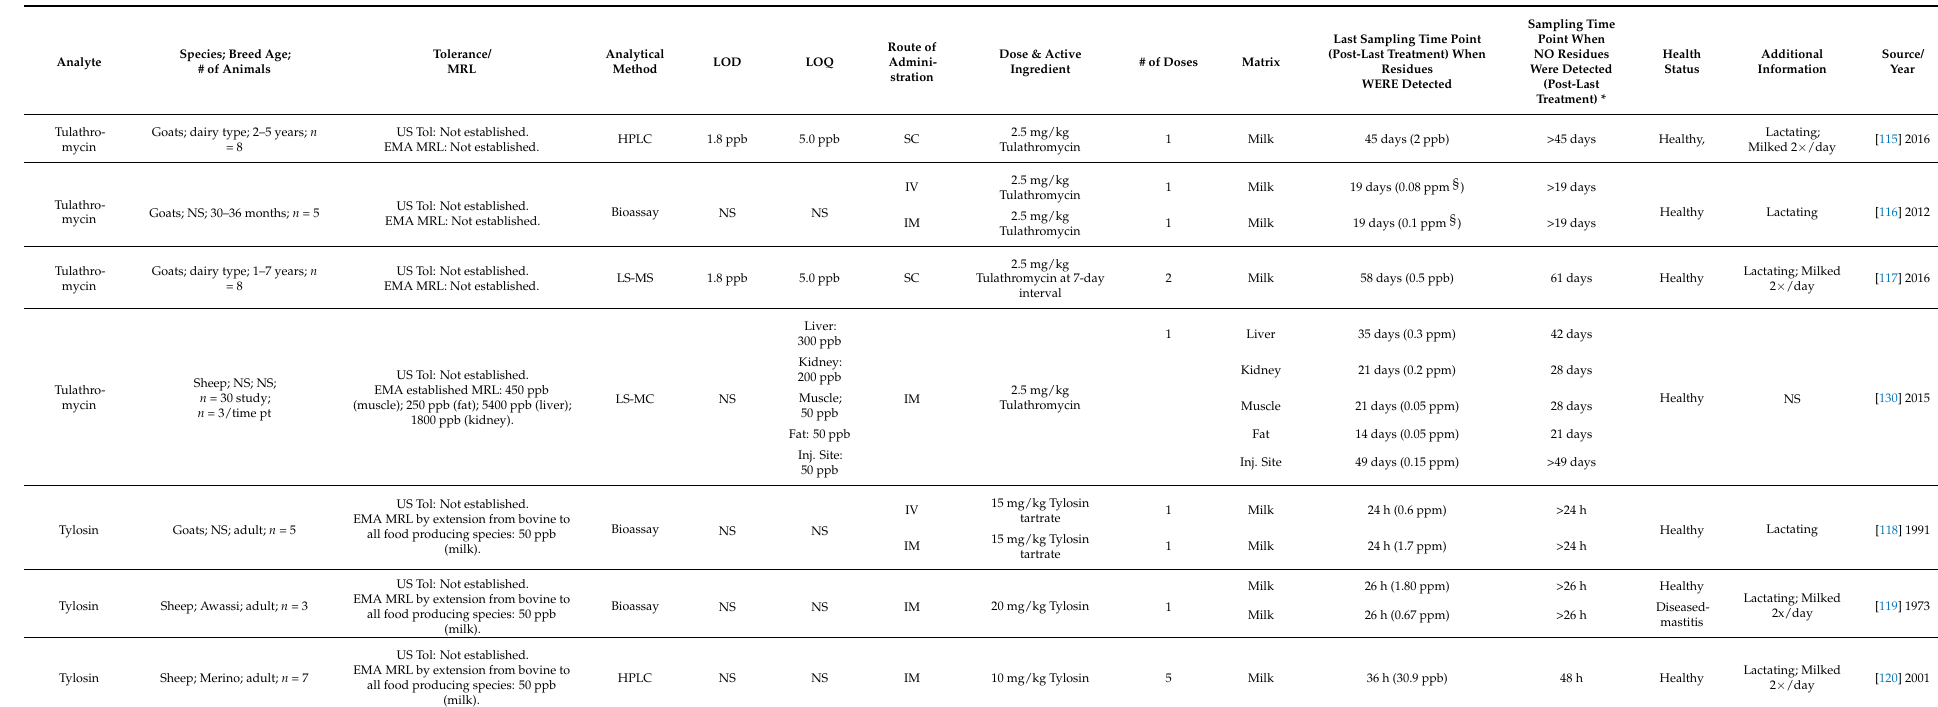
LastSamplingTimePoint (Post-LastTreatment)When